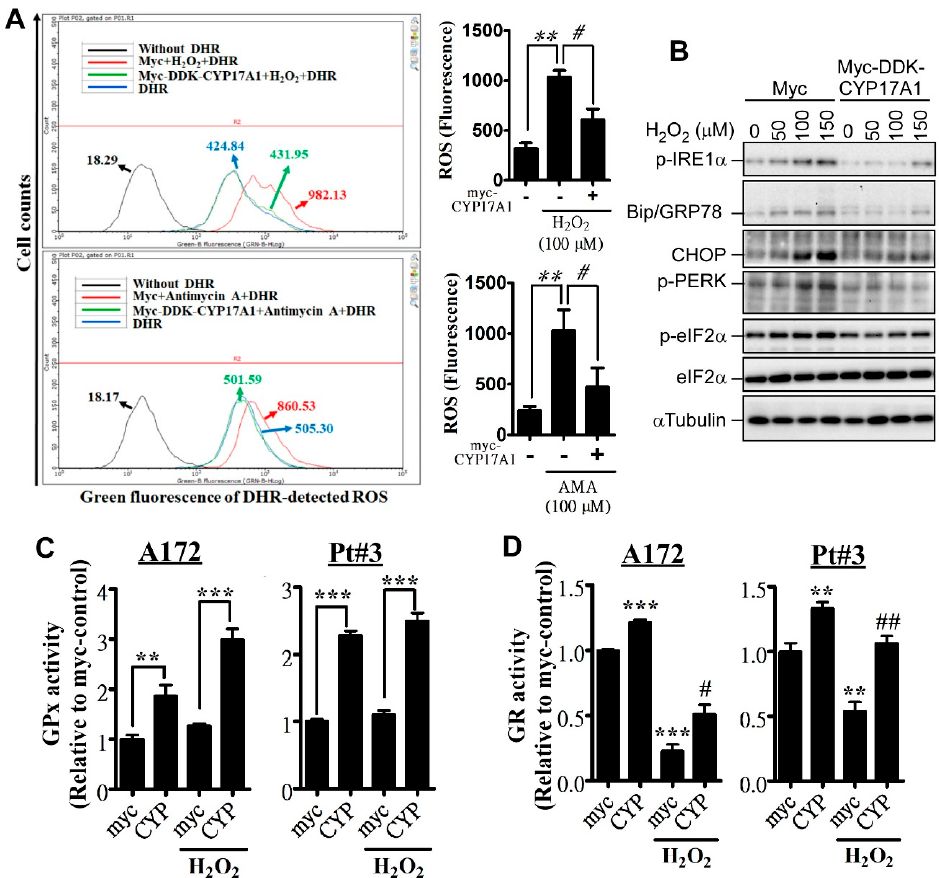
Figure 3. CYP17A1 attenuates hydrogen peroxide-induced ER and oxidative stresses. ( A ) After Figure3. CYP17A1attenuateshydrogenperoxide-inducedERandoxidativestresses. ( A